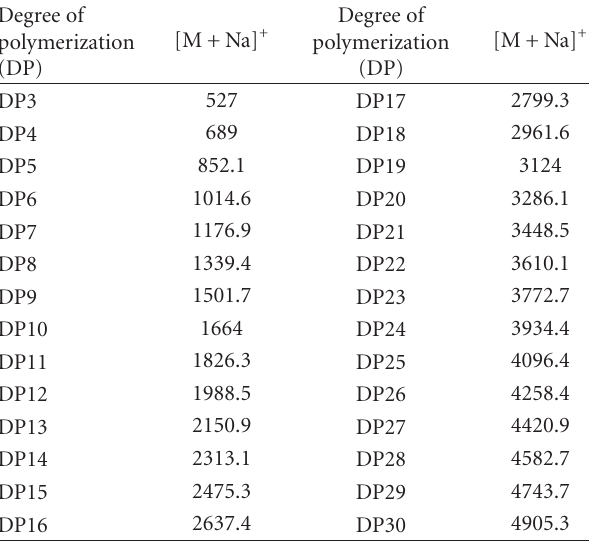
Table 4: Example of sodium adduct and degree of polymerization of Raftiline